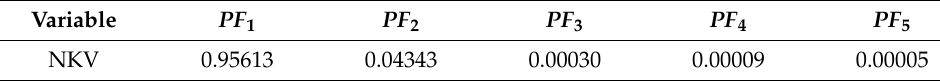
Table 1. Normalized kurtosis values